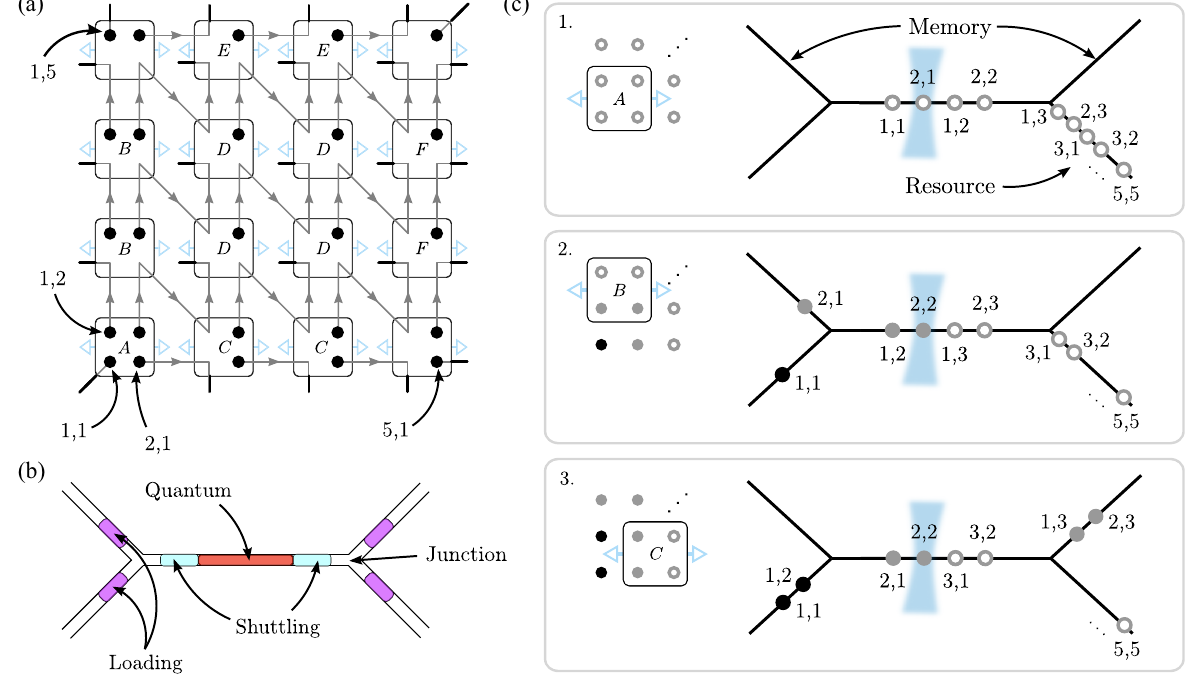
FIG. 16. Tensor-network VQE in a possible architecture of a 2D ion trap. (a) TN representation of a 2D circuit in a system of 5 × 5 ions (circles). Each plaquette couples four qubits to a local phonon mode via sideband operations similar to Fig. 1. Plaquettes labeled by identical letters can share variational parameters to enforce the approximate translational invariance. (b) A suitable linear trap architecture [102]. The quantum region in the center is connected to four branches, which serve as loading and memory zones. Ions can be shuttled in between regions by precise control of local trap potentials. (c) Possible implementation of the 2D circuit via sideband and shuttling operations. We show the first three steps in the circuit with all participating ions shuttled to their respective positions. Here, empty gray circles indicate ions that have thus far not participated in the circuit, while those in solid gray have already been addressed and must be kept for later use in different plaquettes. Black circles highlight ions that have already dropped out of the circuit and remain from this point on